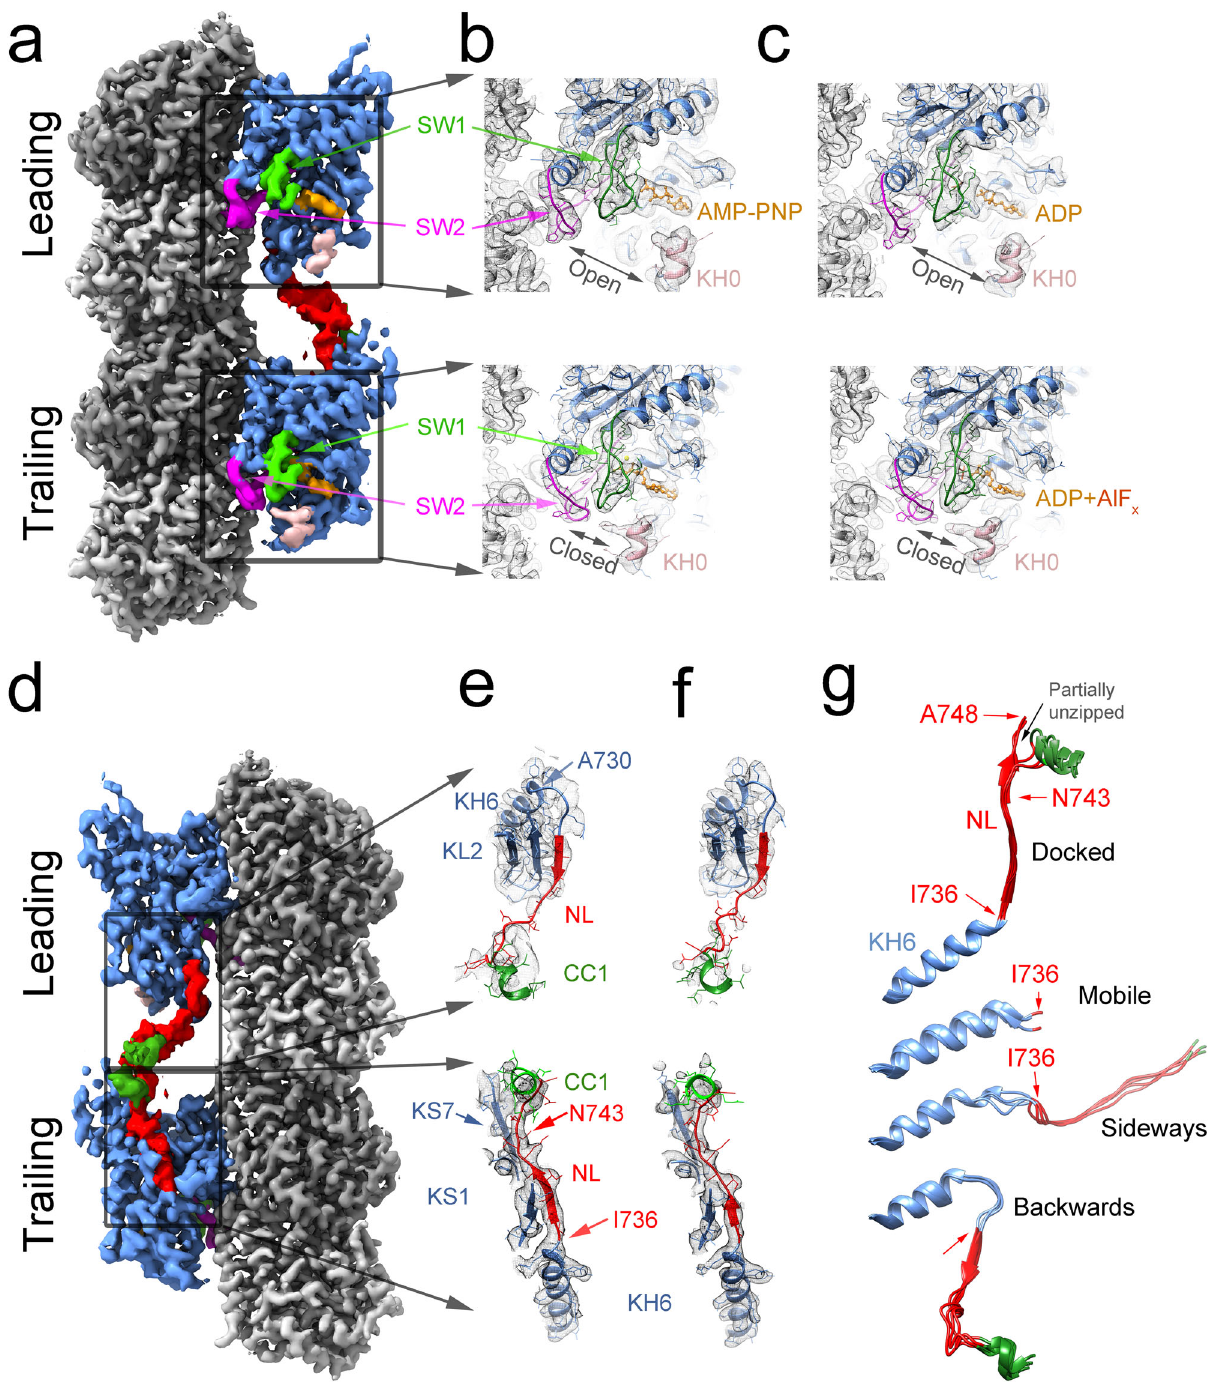
Fig. 7 Leading and trailing KIF14 motor domain structures. a Cryo-EM iso-density surface representation of the MT-K755-ANP HASRC re fi ned two- heads-bound structure. b Detail of the nucleotide-binding pocket of the leading and trailing heads of the MT-K755-ANP structure. c Similar views as ( b ) of the MT-K772-AAF structure. d 180° rotation of structure shown in ( a ). e Detail of the KH6 and neck-linker regions of the leading and trailing heads of the MT-K755-ANP structure. f Similar views as ( e ) of the MT-K772-AAF structure. g Different KH6-neck-linker con fi gurations observed in the MT-KIF14 structures (see Table 2 for their correspondence to particular structures). Cryo-EM densities shown as iso-densities colored surfaces ( a ) and ( d ) with the leading head neck-linker and coiled coil regions displayed at a lower contour level value than the rest of the map. α -tubulin in light gray, β -tubulin in dark gray. KIF14 motor domain in blue with SW1 in magenta, SW2 in bright green, KH0 in pink, the neck-linker in red, CC1 in dark green, and the bound nucleotide in orange. Same color scheme is used for the ribbon representation atomic models shown in ( b , c , e – g ). Cryo-EM map densities shown as gray mesh iso-density surfaces in ( b , c , e , f